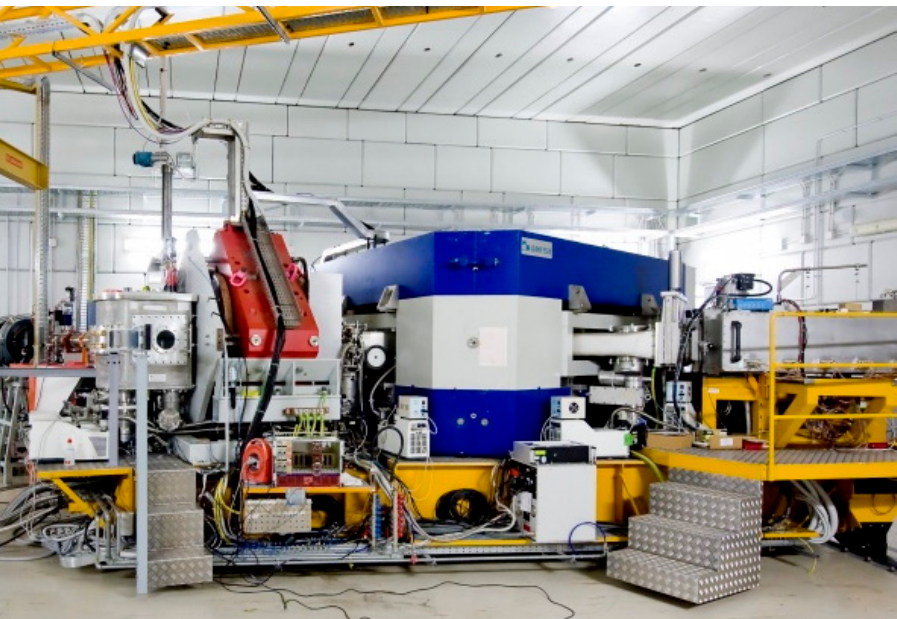
Figure 2. Global view of the MAGNEX spectrometer in the current configuration.